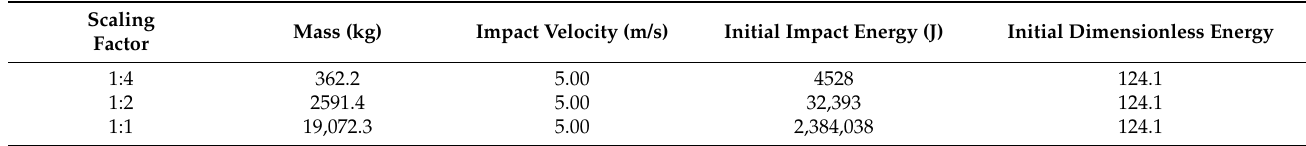
Table 4. Mass property, impact velocity and energy in finite element analysis.